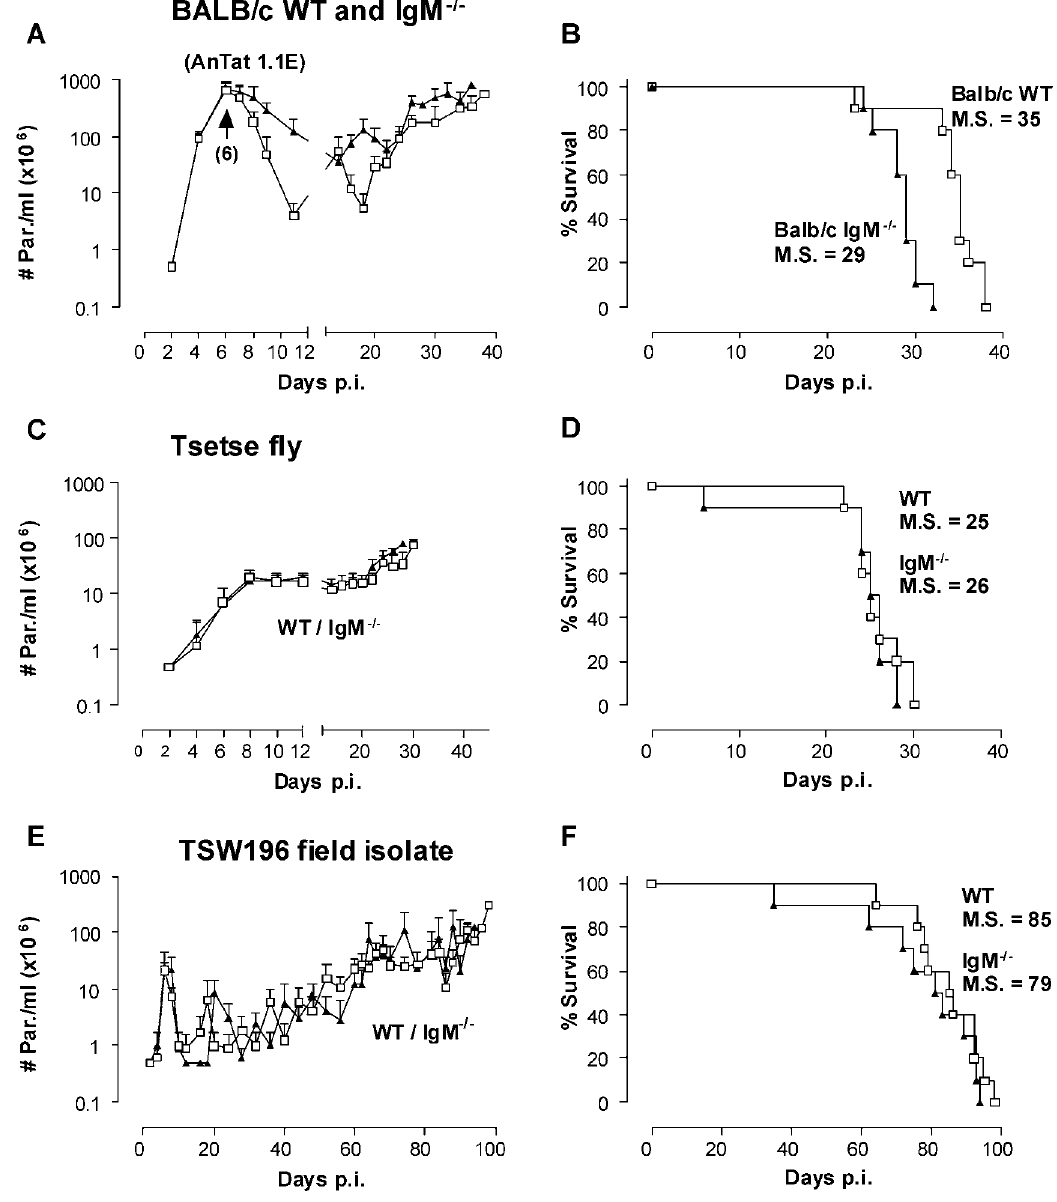
Figure 2. The effect of IgMs in high-, intermediate- or low-virulent infections. BALB/c WT ( % ) and IgM 2 / 2 ( m ) mice were infected with (A/B) 5000 parasites of the pleomorphic AnTat 1.1E clone by intra-peritoneal injection, (C/D) non clonal T. brucei AnTaR 1 parasites through exposure to tsetse fly or (E/F) with 5000 parasites of the low virulent field isolate TSW196 by intra-peritoneal injection. Parasitemia and mortality of infected mice was assessed as in Fig. 1, using 10 mice per experimental group. M.S.=median survival time.